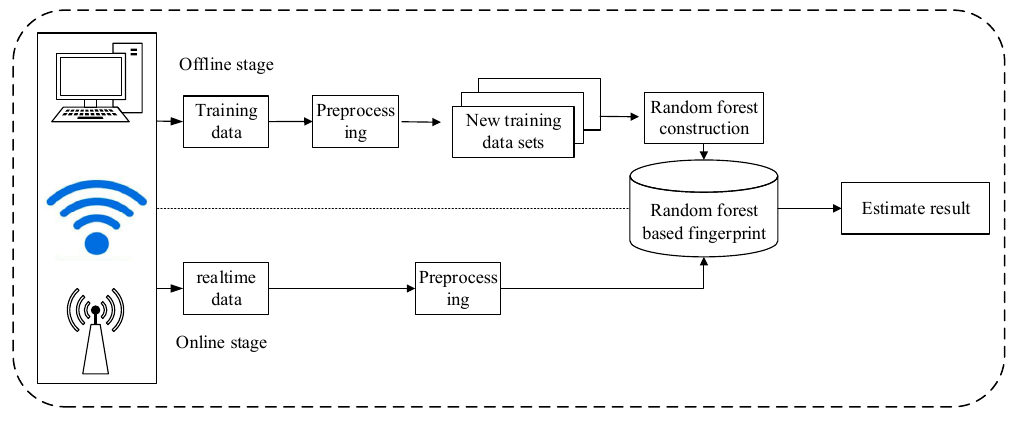
Figure 4. WiGId method flow chart.